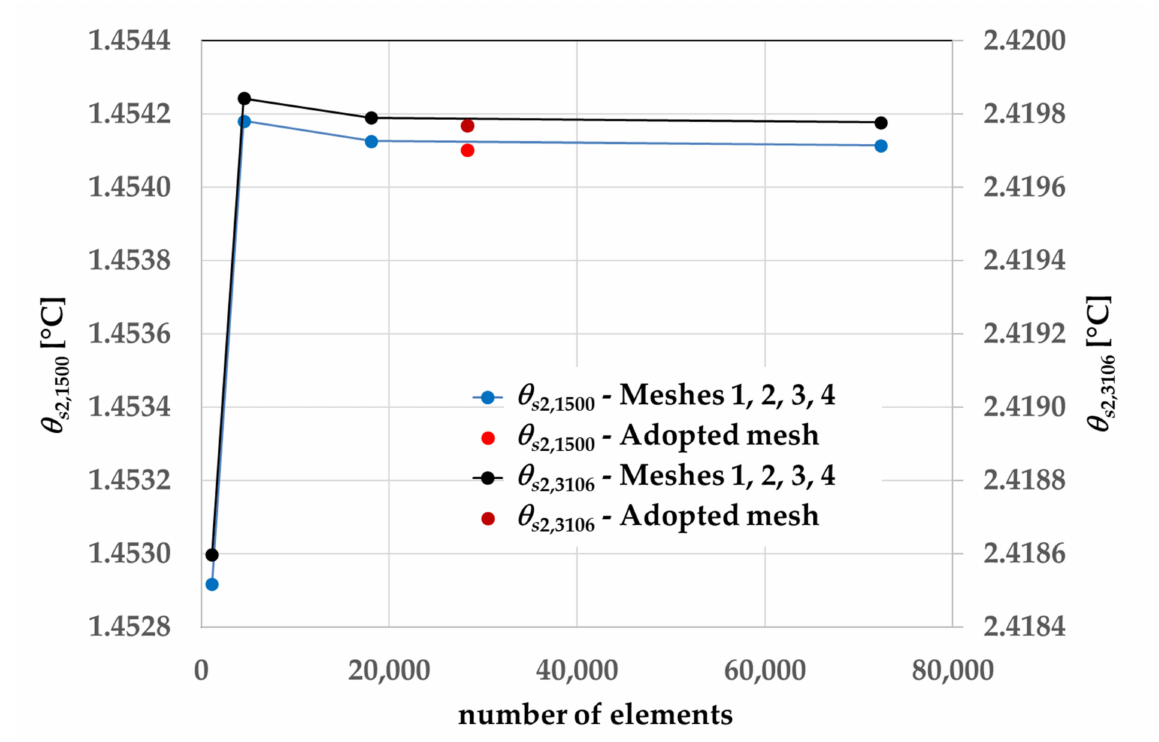
Figure 6. Preliminary estimate of α s : convergence of the values of θ s 2 yielded by Meshes 1, 2, 3, and 4 to those yielded by the adopted mesh, for t = 1500 min and t = 3106